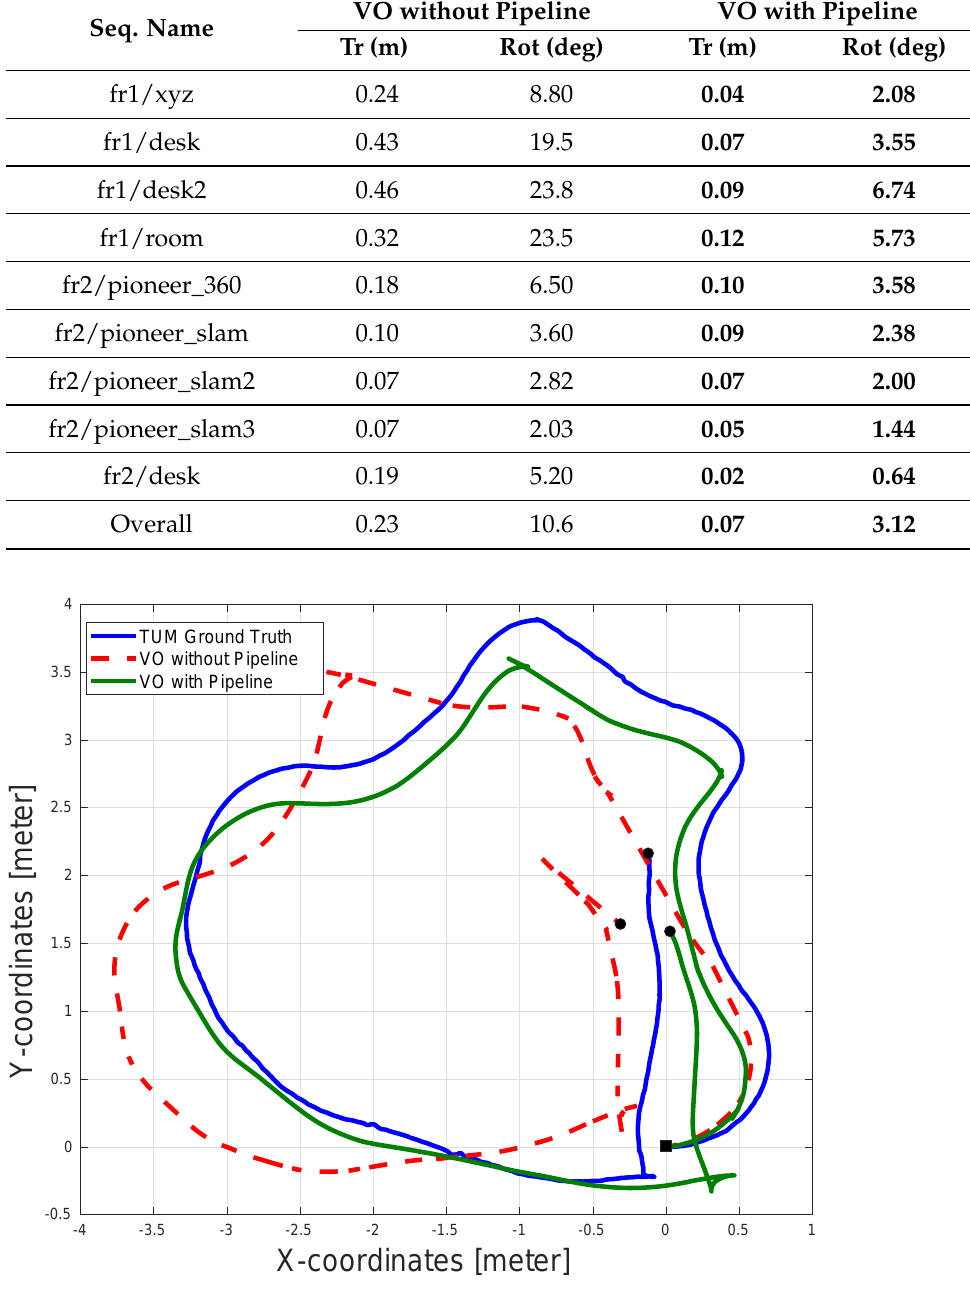
Figure 9. The pose estimation results for the sequence fr1/pioneer_360 in the TUM dataset with and without the pipeline along with the dataset ground-truth. The pose estimation accuracy of the VO with the pipeline is superior, while the VO without the pipeline suffers from both poor translation and orientation estimation. The black square represents the start of the paths and the black circles represent the ends of the